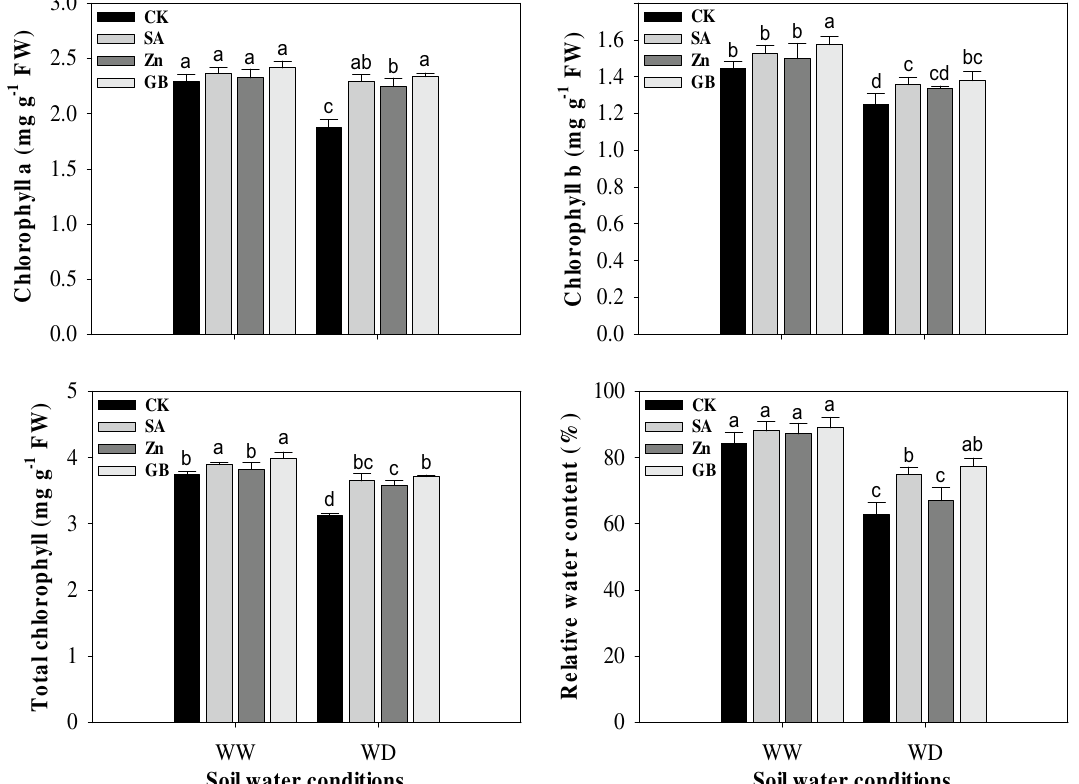
Figure 1. Effect of soil water conditions and foliar treatments on chlorophyll a, chlorophyll b, total chlorophyll, and relative water contents. Every column in each graph represents the mean (± SE) of three replicates. Different letters above columns indicate that means are different at 95% confidence level. WW, well-watered; WD, water- deficient; CK, control (double distilled water); SA, salicylic acid; Zn, Zinc; GB, Glycine